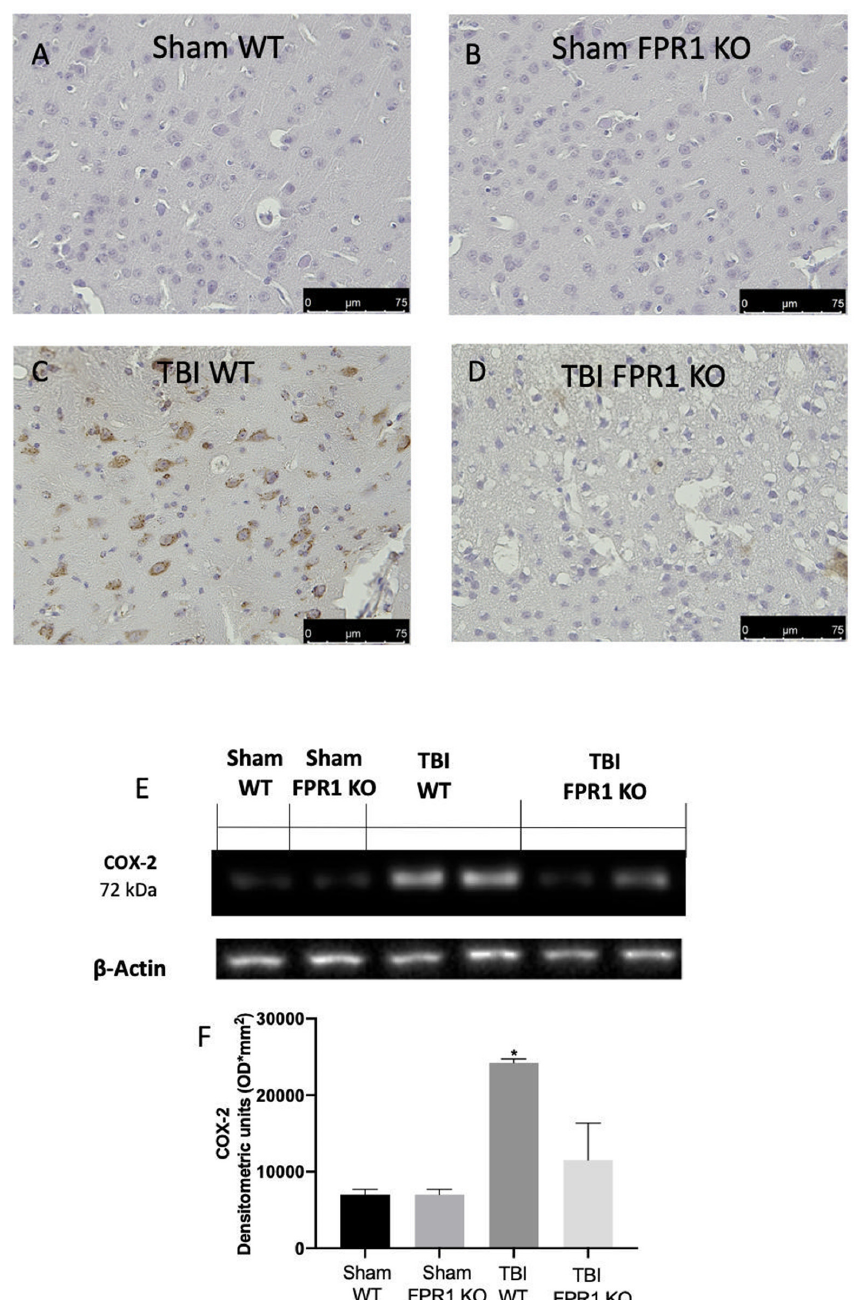
Figure 11. Effect of the absence of Fpr1 on COX-2 expression four weeks after TBI: Immunohistochemical analysis displays an increased COX-2 ( C ) expression in TBI WT mice compared to the Sham WT ( A ) and Fpr1 KO animals ( B ) while TBI Fpr1 KO animals do not show any increase ( D ) Western blot analysis confirmed the increase in COX-2 expression in TBI WT mice compared to the sham groups. COX-2 expression was significantly reduced in TBI Fpr1 KO animals ( E , F ) For the analyses, n = 5 animals from each group were employed. Results were analyzed by two-way ANOVA followed by a Bonferroni post-hoc test for multiple comparisons. Non-parametric data were analyzed with Fisher’s exact test. * p < 0.05 vs. Sham WT. scale bar 75 m.